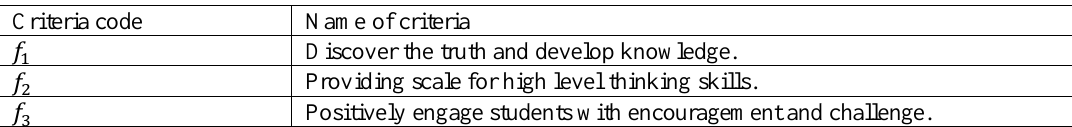
Table 1. Example criteria.